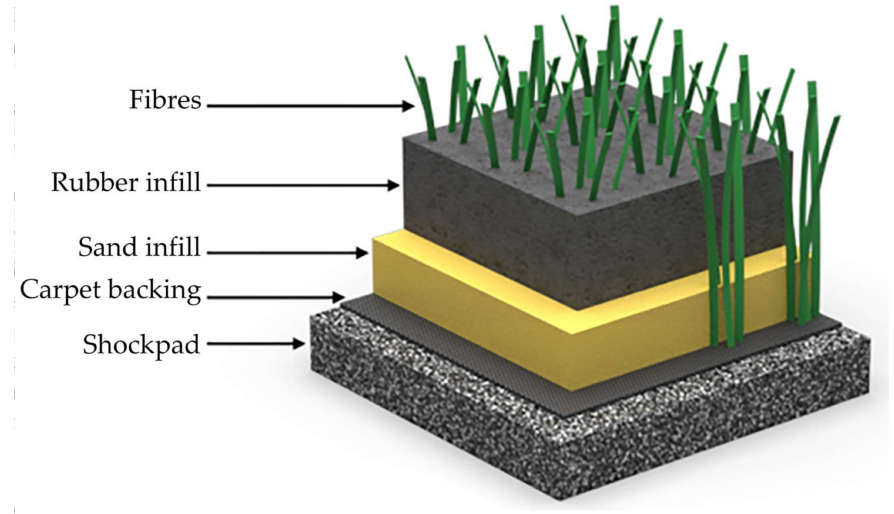
Figure 1. Layered construction of 3G turf